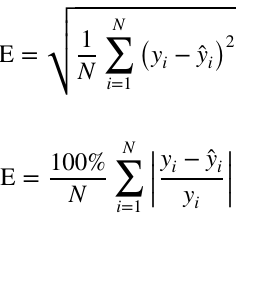
Table 1 Comparison of different models for forecasting multi-step electrical load